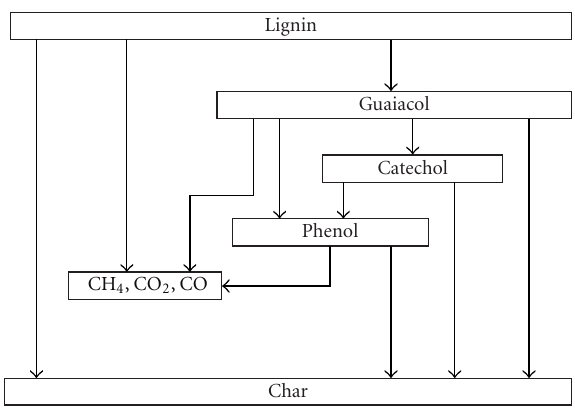
Figure 1: Possible reaction pathways for hydrothermal lignin